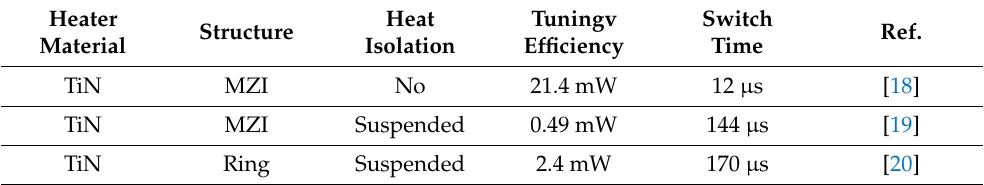
Table 1. Performance comparison of thermo-optic phase shifter on Si channel